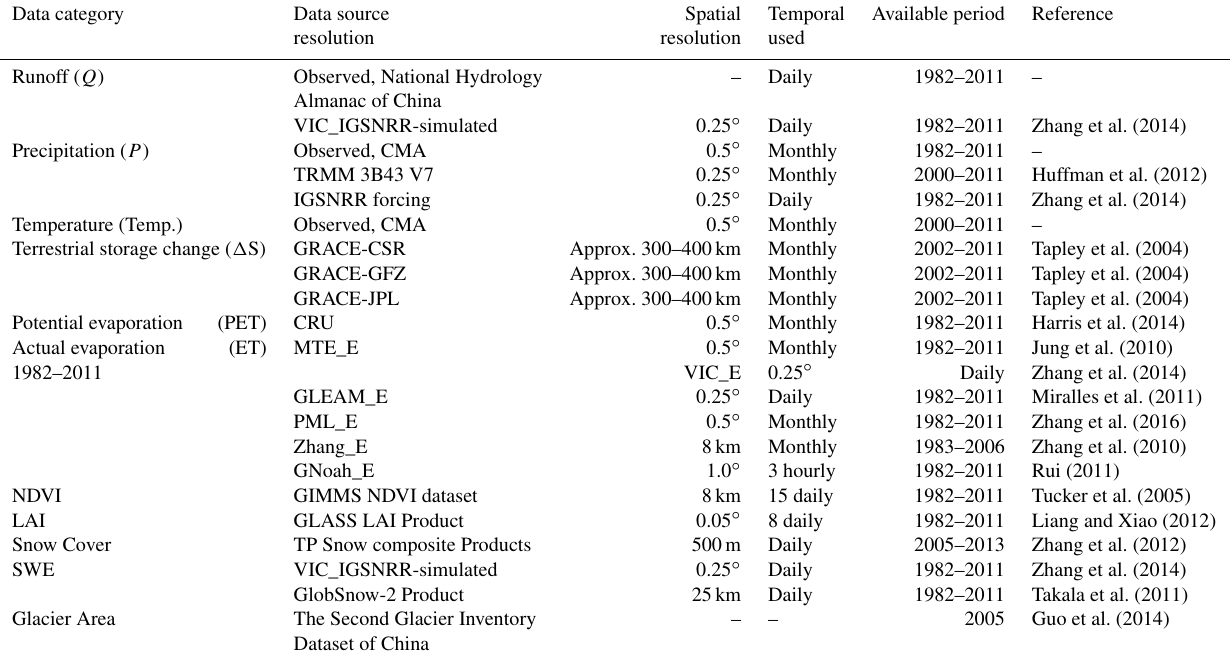
Table 1. Overview of multi-source datasets applied in this